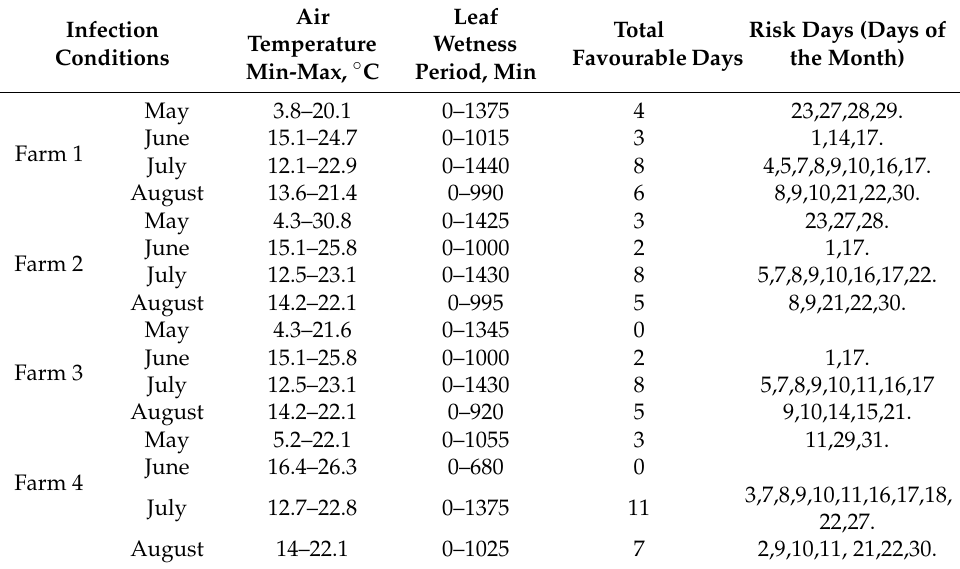
Table 3. Conditions for strawberry C. acutatum development, according to iMETOS ® meteorological station data in